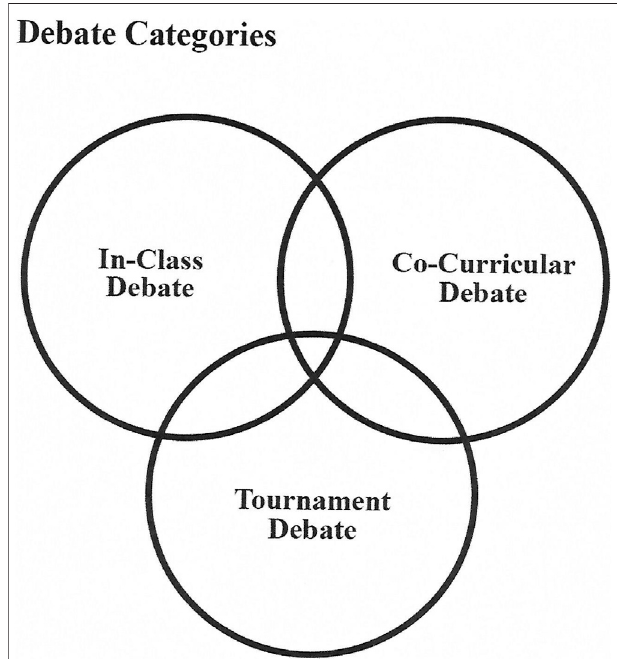
FIGURE 1 | Debate